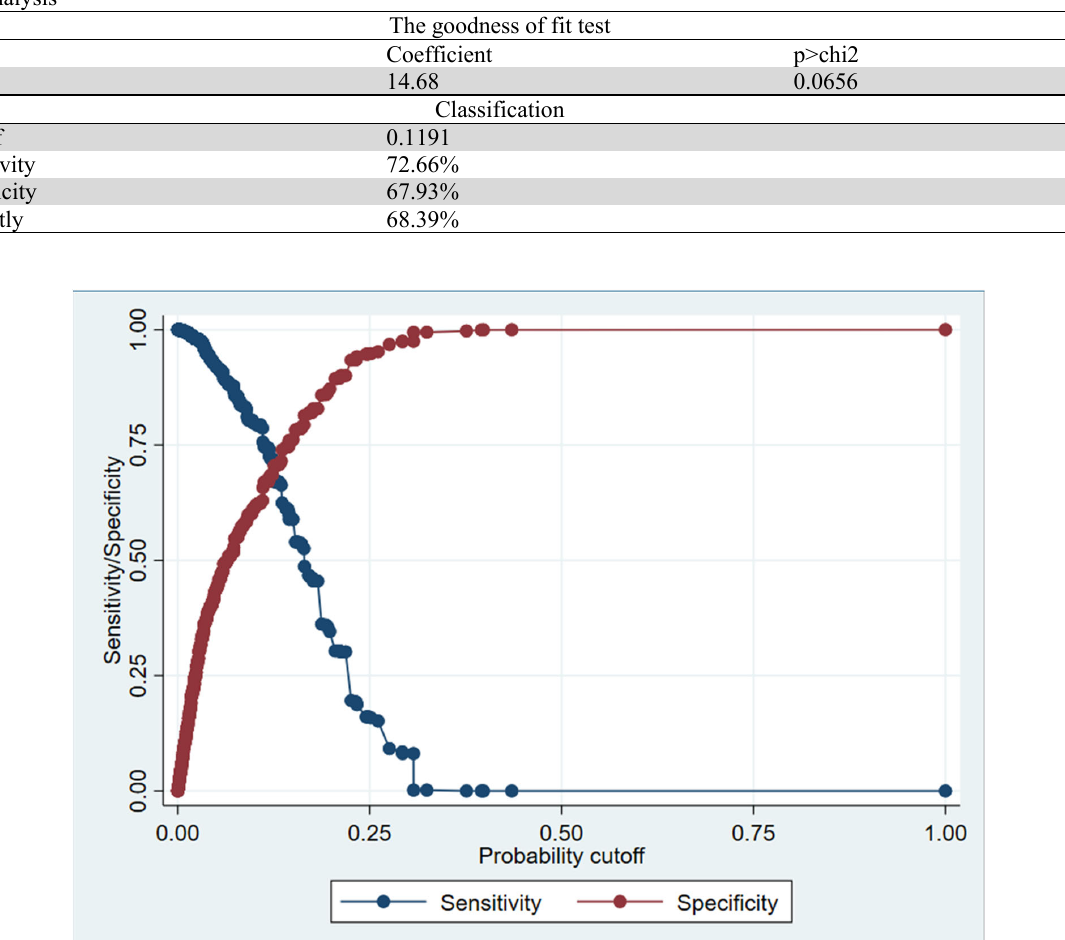
Fig. 1. Sensitivity-Specificity